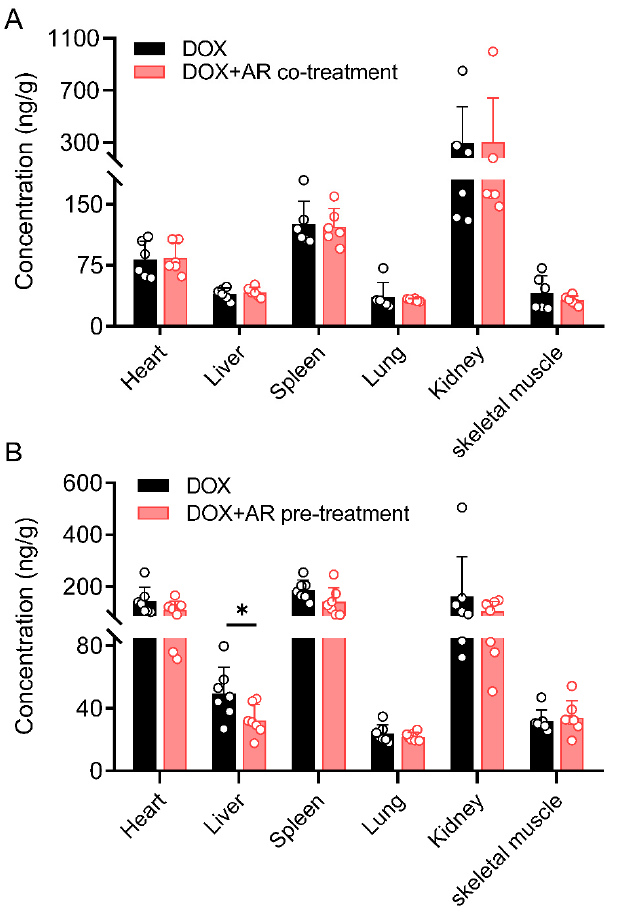
Figure 3. Astragali Radix (AR) has little effect on the tissue distribution of doxorubicin (DOX). ( A ) Tissue distribution of DOX at 48 h after intravenous injection of DOX (5 mg/kg) alone and the co- treatment with AR (10 g/kg). ( B ) Tissue distribution of DOX at 48 h after intravenous injection of DOX (5 mg/kg) alone and the pre-treatment with AR (10 g/kg × 10). All data are presented as mean ± SD. Student t -test, * p < 0.05.